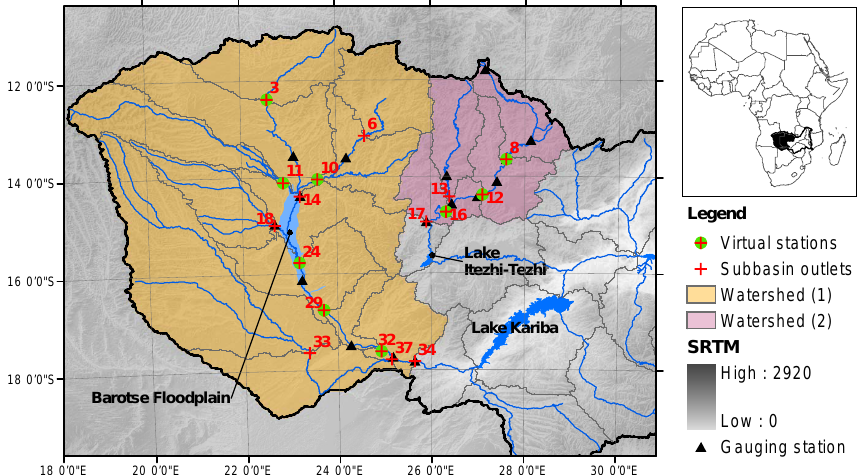
Fig. 1. Study area and location of subbasins and VS (only gauging stations on modeled reaches with data during either the calibration or validation are